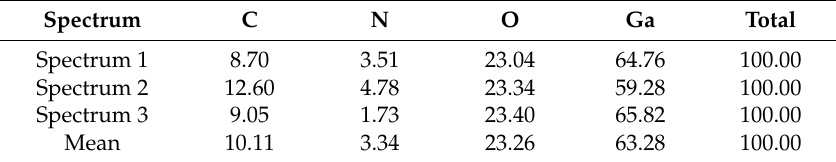
Table 2. Elemental composition of product synthesized from a Ga(NO 3 ) 3 ∙32H 2 O pellet and C 3 H 6 N 6 powder injection with NH 3 gas by the thermal plasma process in Plasma 4 (all results in % of weight).